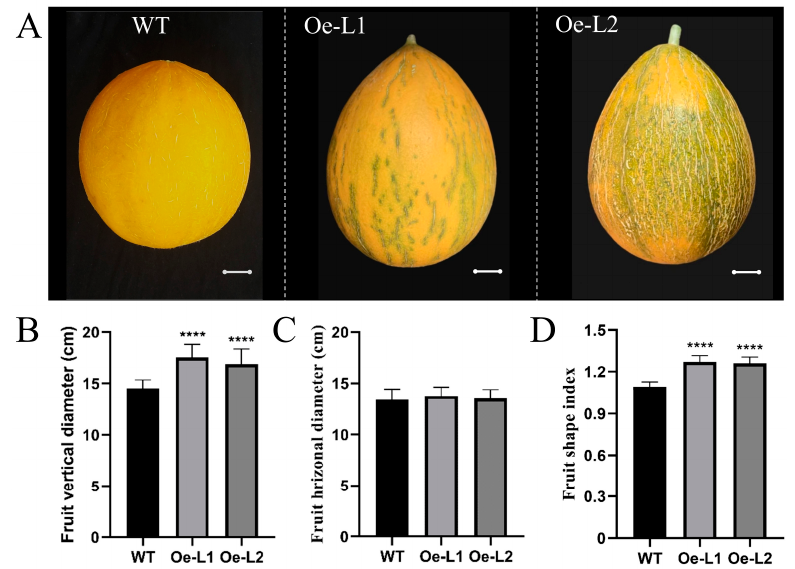
Figure 6. Phenotypic analysis of CmSUN25-26-27c -overexpressed transgenic lines. ( A ) Phenotypic observation of the fruits in transgenic lines. ( B ) Fruit vertical diameter significantly increased in transgenic lines. ( C ) Fruit horizonal diameter comparison between transgenic lines and WT. ( D ) Statistical analyses of fruit shape index in transgenic lines and WT. Scale bars = 2 cm. Oe-L1 and Oe-L2 indicate CmSUN25-26-27c -overexpressed transgenic lines. **** p value < 0.0001.